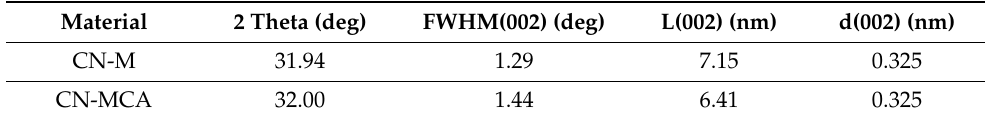
Table 3. Some XRD parameters of CN